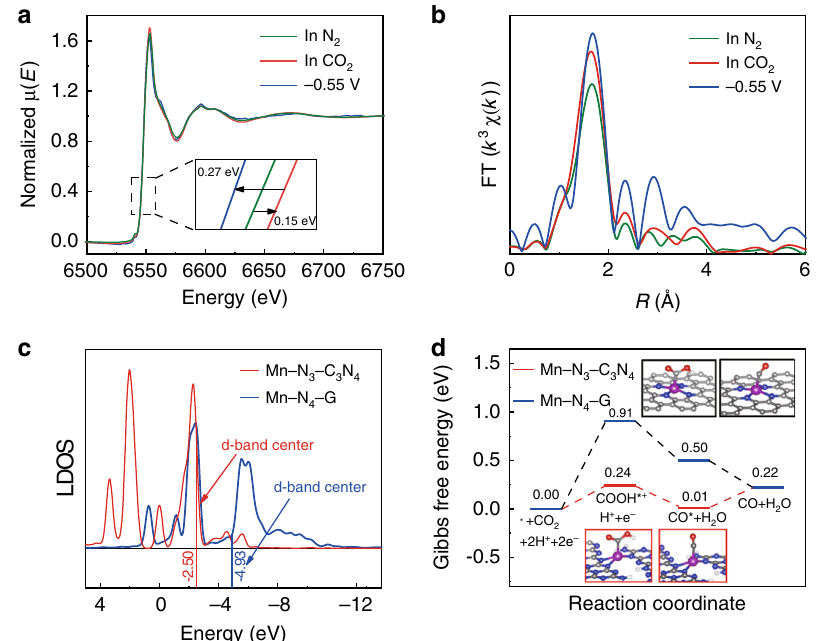
Fig. 4 In situ XAS experiments and DFT calculations. a , b XANES and EXAFS spectra at the Mn K-edge of Mn – C 3 N 4 /CNT under various conditions. c Local density of states (LDOS) of Mn in Mn – N 3 – C 3 N 4 and Mn – N 4 -G. d Calculated Gibbs free energy diagrams for CO 2 RR over Mn – N 3 – C 3 N 4 and Mn – N 4